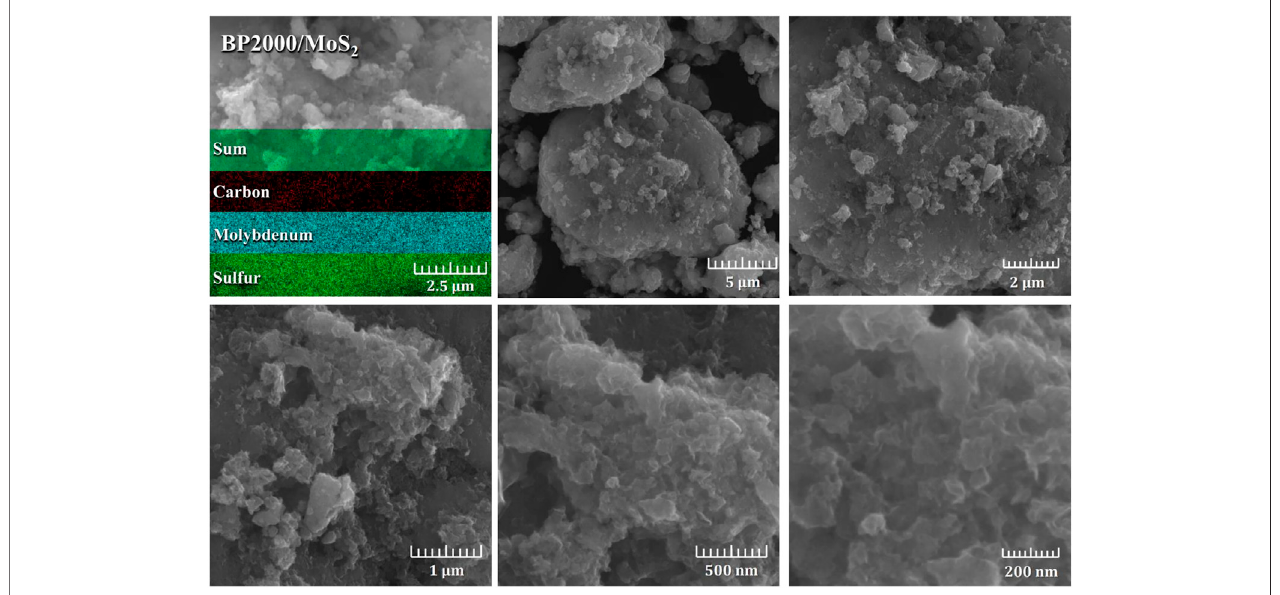
FIGURE 3 | EDS and SEM images of BP2000/MoS 2 at different magni fi cations.